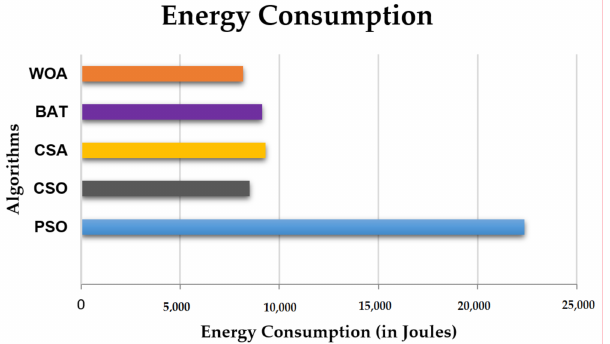
Figure 10. Comparison of the energy consumption of the PSO, CSO, CSA, BAT with WOA algorithms.